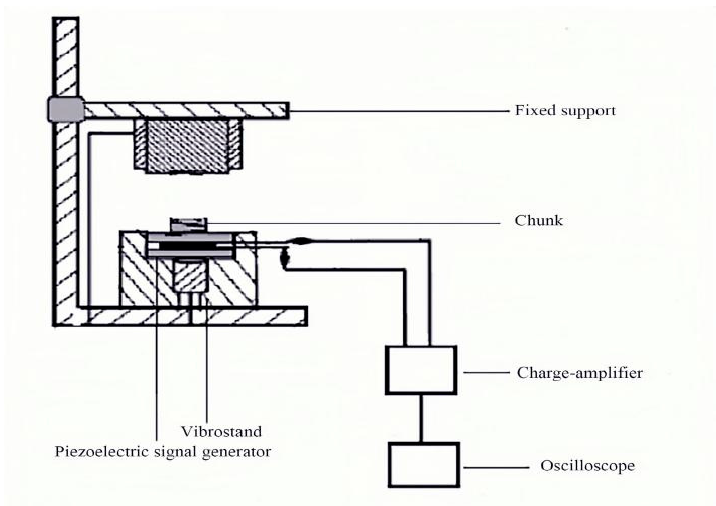
Figure 4. Piezoelectric test device.